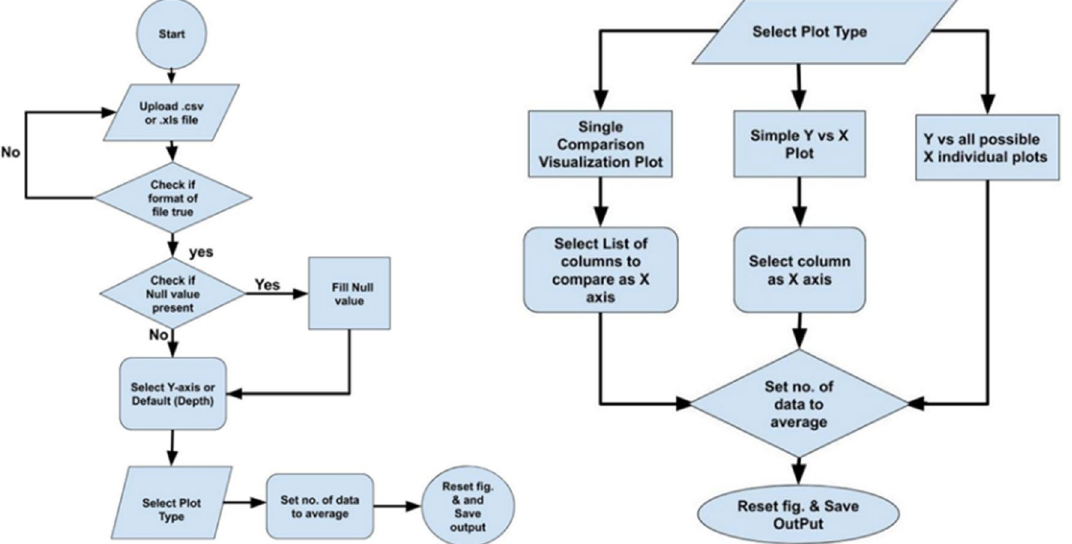
Figure 10. Flow chart of TKinter GUI based on PYTHON